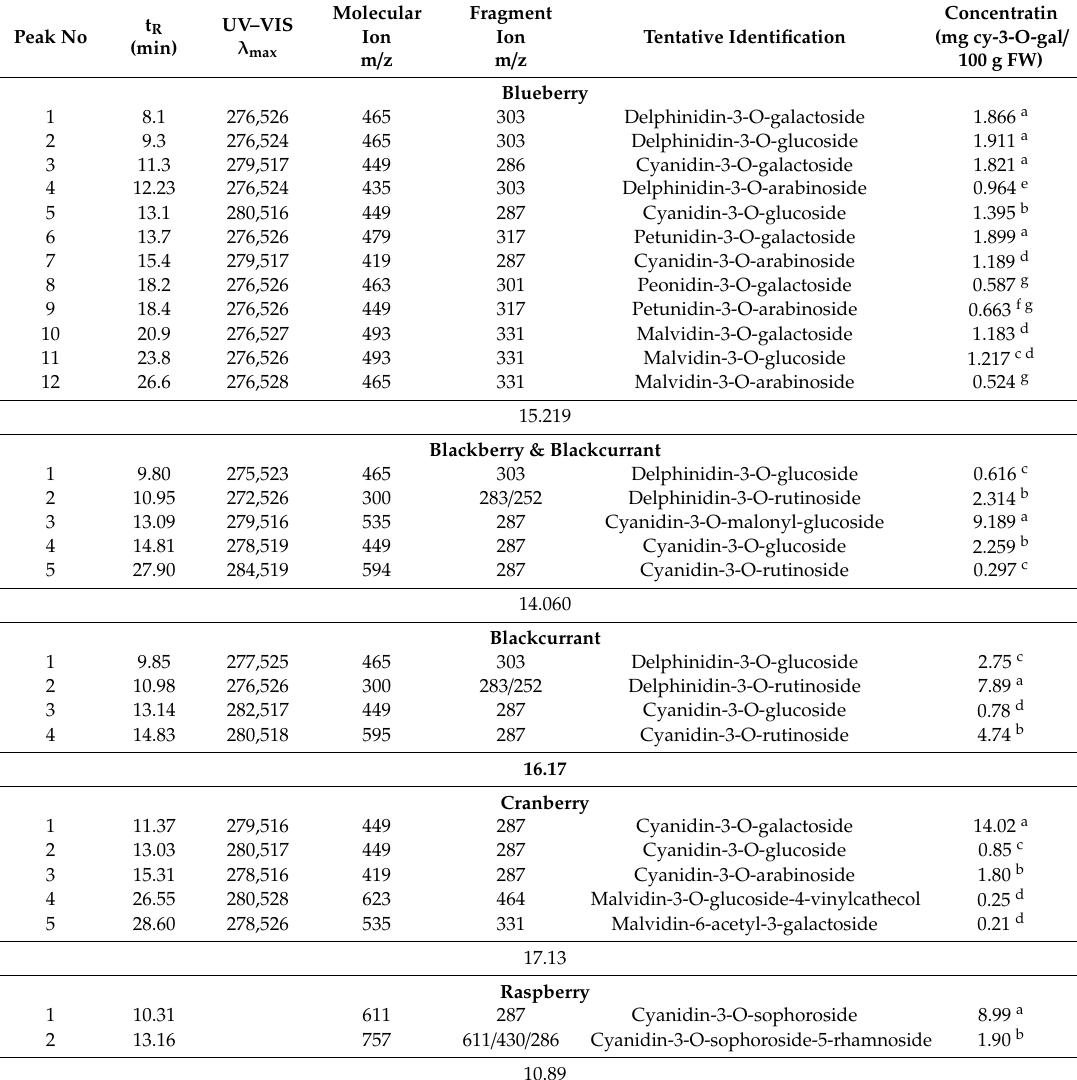
Table 3. Retention times, UV–VIS max. absorption wavelengths, tentative identification, and concentration of anthocyanins in berry jams expressed in mg cyanidin-3- O -galactoside per gram of jam (fresh